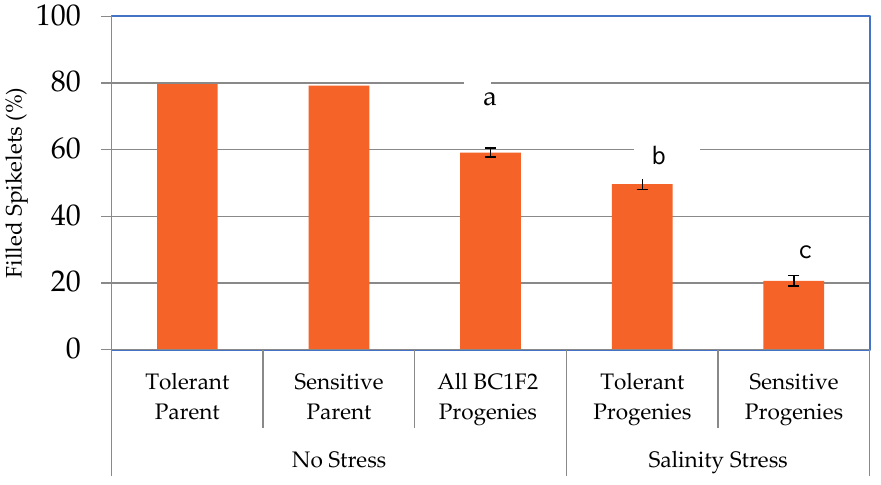
Figure 1. Percent filled spikelets per plant of tolerant and sensitive parents under no stress and their BC 1 F 2 progenies under no stress and salt stress condition. Vertical and capped bar indicates standard error of the mean percent filled spikelets of 153 progenies under no-stress, 78 tolerant and 112 sensitive progenies under salinity stress. Values with the same letter are not significantly different at 5% level of significance.